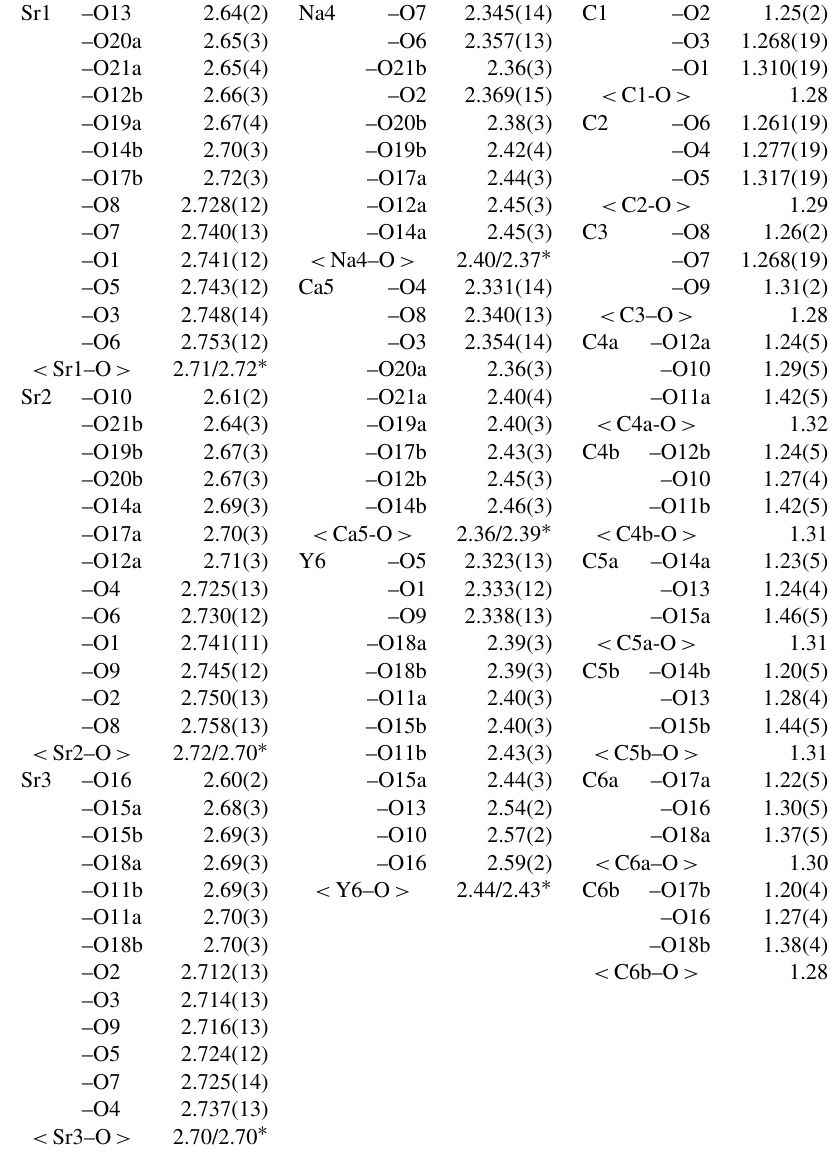
Table 7. Selected interatomic distances (Å) in the structure of